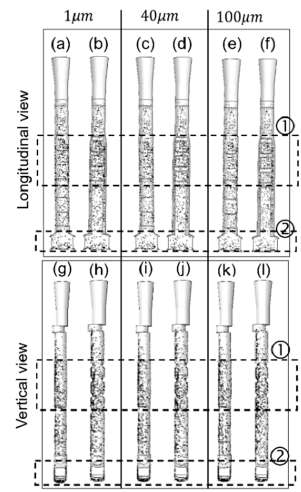
Figure 4. Touching inclusion distribution along both nozzle types for three inclusion